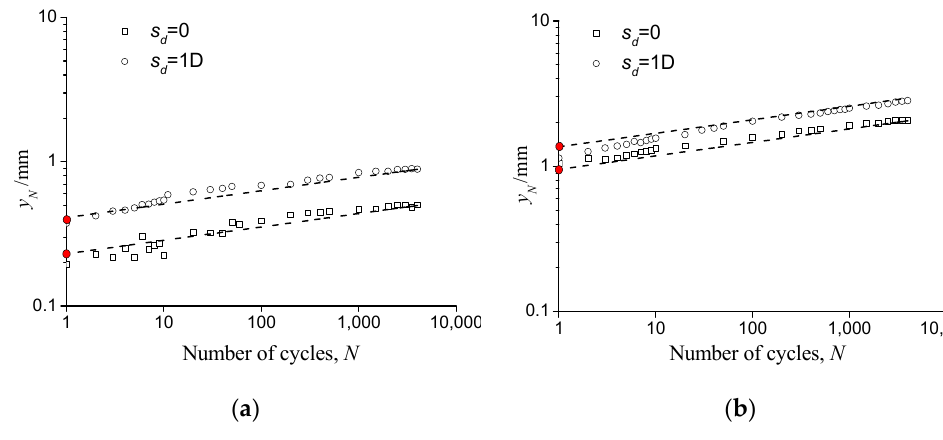
Figure 16. Illustrative plot to obtain y (cid:2869) . ( a ) α = 0°,